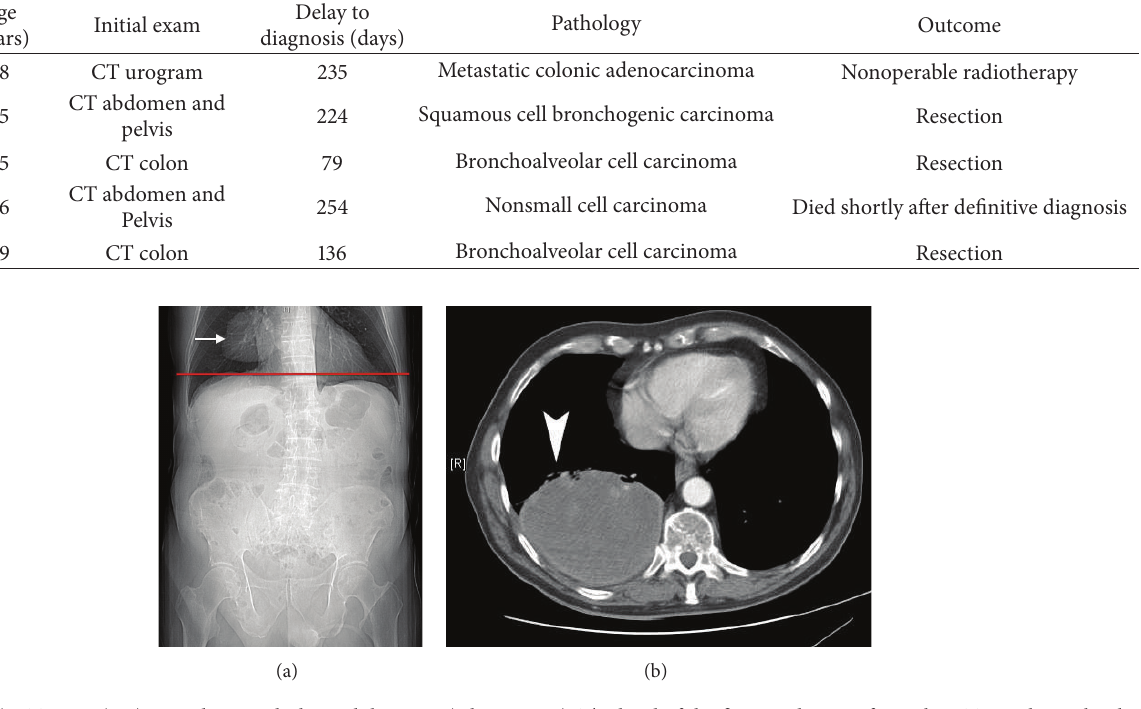
Figure 1: (a) CT scout (AP) view: large right lower lobe mass (white arrow). The level of the first axial image from the CTU is shown by the red line demonstrating that the scan commenced below the level of the lesion. (b) Image from the subsequent CT chest scan confirming a right lower lobe mass